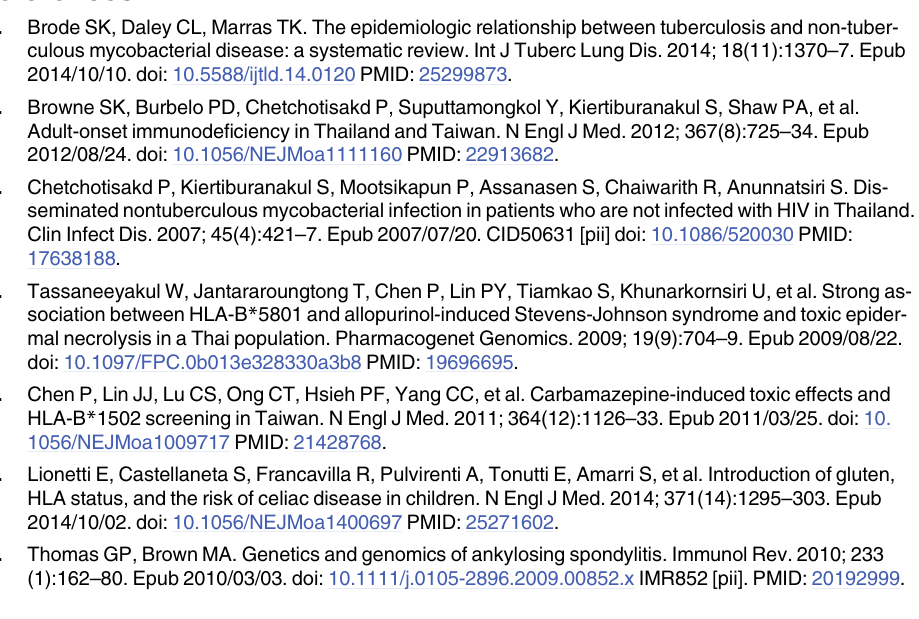
S2 Table. Allele frequencies of HLA-DRB1 among 32 cases and 30 healthy controls. S3 Table. Allele frequencies of HLA-DPA1 and HLA-DPB1 among 32 cases and 30 con-